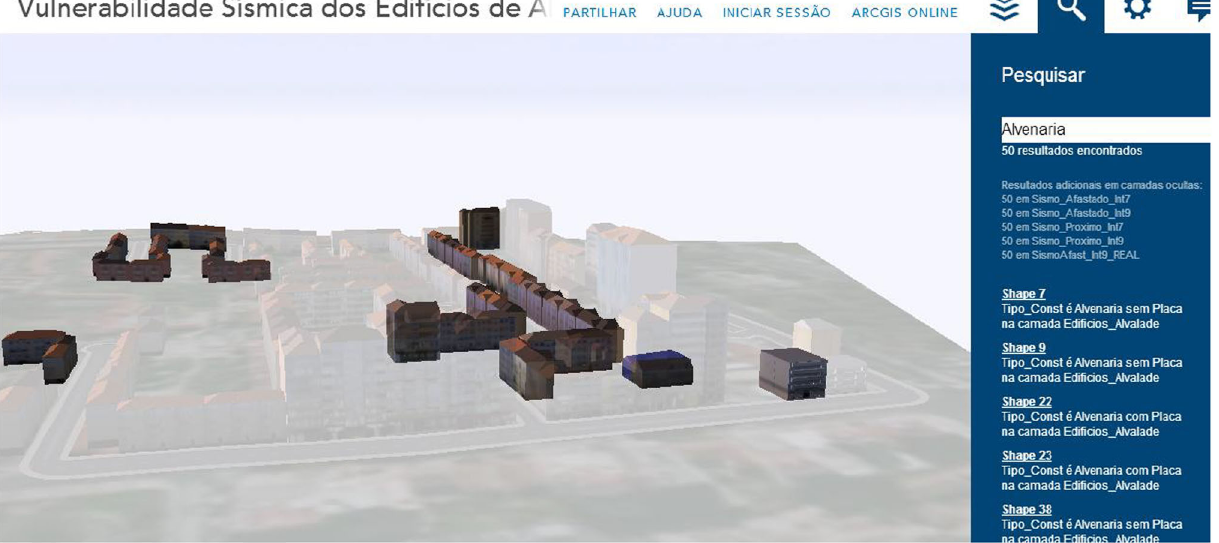
Fig. 3 CityEngine web viewer layout example: result of the query ‘‘Type of construction: Masonry—Alvenaria (in Portuguese)’’ for the pilot area Alvalade; (left) highlighted buildings in 3D scene matching